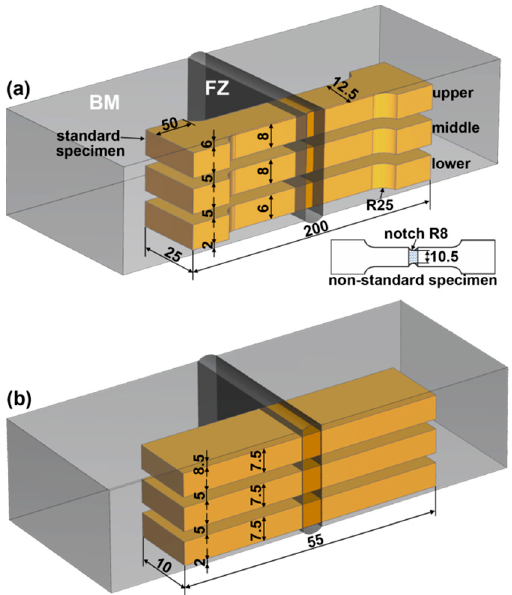
Figure 2. Cutting location and dimension size of the specimens, ( a ) ultimate tensile strength (UTS); ( b ) impact absorbing energy (IAE).